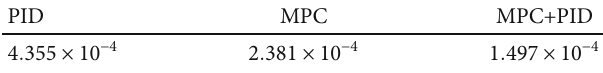
Table 3: Performance index based on